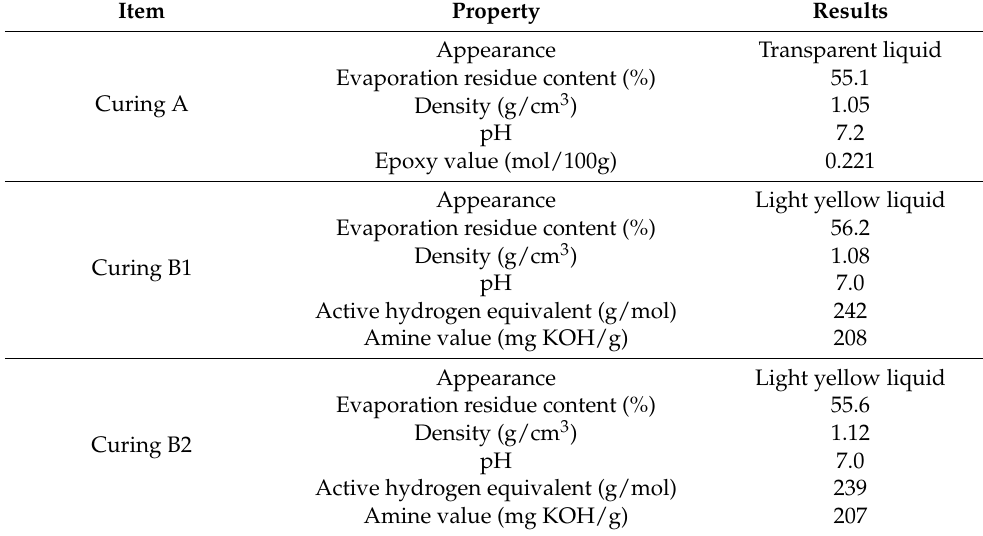
Table 2. Parameters of